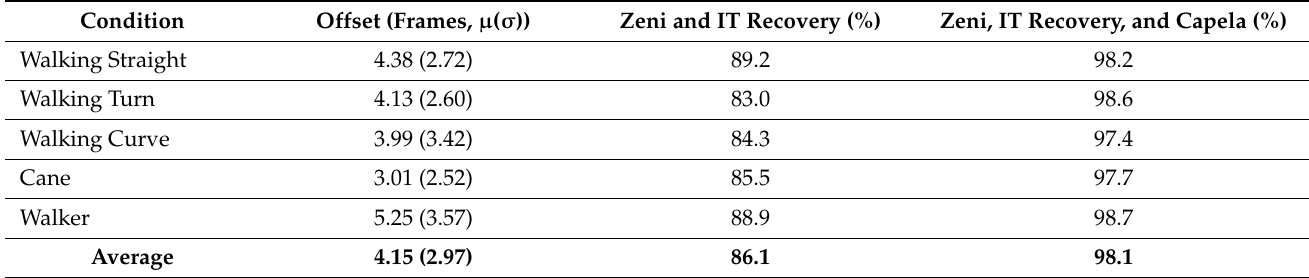
Table 6. Detected foot events frame offset from ground-truth values (mean and standard deviation in brackets) across both participants. The percentage of events detected using Zeni [30] and IT recovery algorithms in combination is shown alongside the percentage of events detected using all the proposed foot-event detection methods.